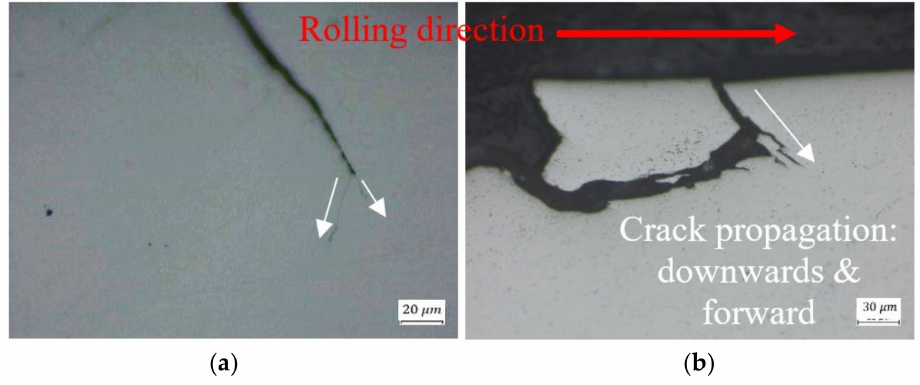
Figure 15. Crack propagation ( a ) into the material depth, and ( b ) towards the rolling direction. The white arrows represent the direction of cracks